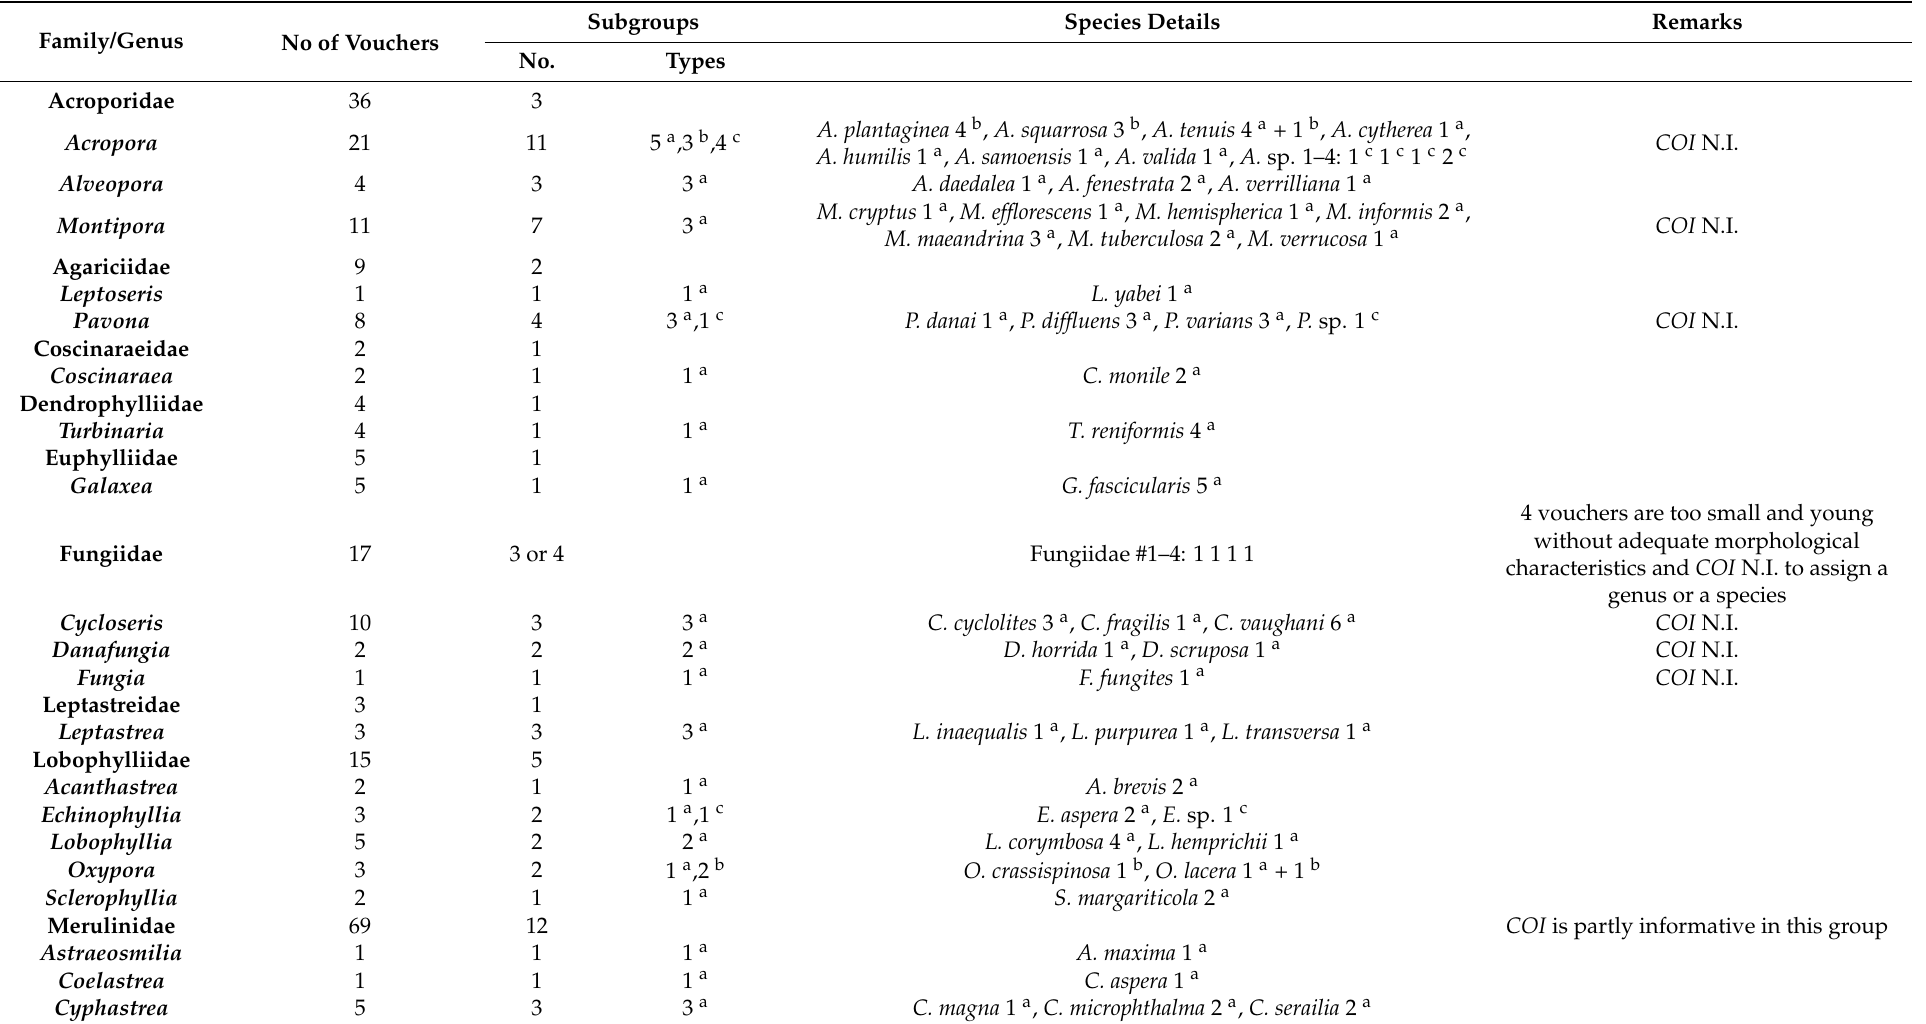
Table 1. List of coral families, genera, and species from Eilat with counts of vouchers, and of representatives in each taxonomic subgroup. a —voucher fully identified, b —voucher identified as cf., c —voucher not fully identified. COI N.I.— COI Not Informative (requiring additional molecular markers for complete